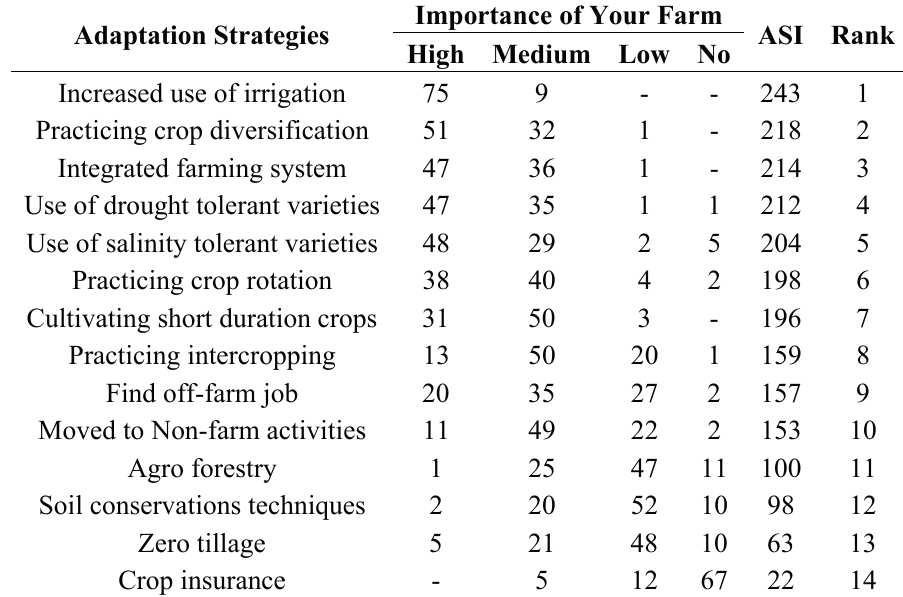
Table 3. Ranked order of the adaptation strategies to climate change ( n =